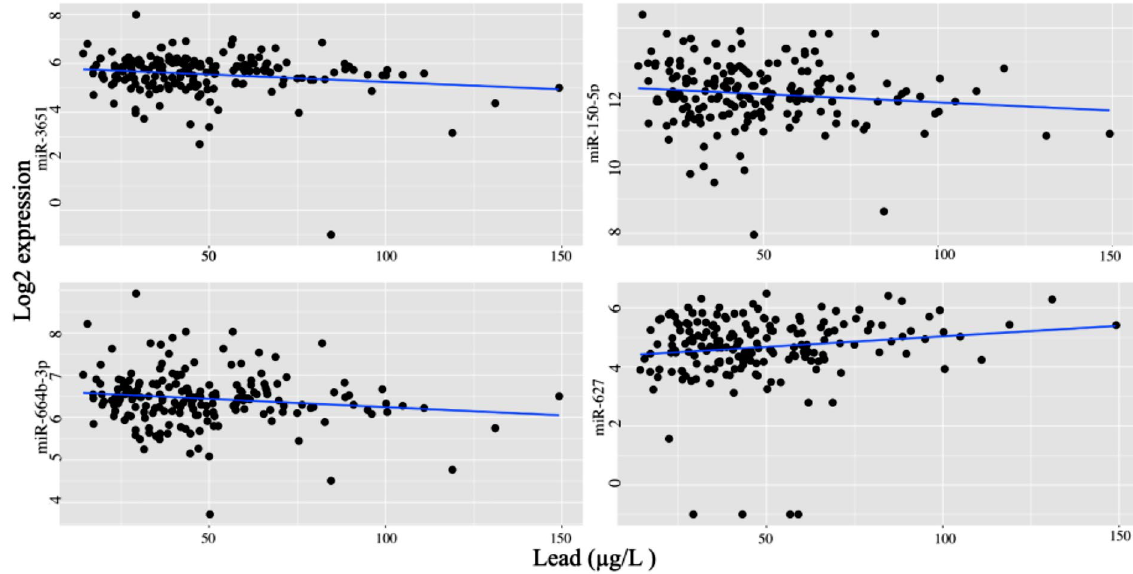
Figure 2. The scatterplot showed expression levels of four miRNAs associated with lead exposure. Scatter plot of the expression of 4 miRNAs (miR-3651, miR-664b-3p, miR-150-5p, and miR-627), identified in the EnviroGenomarker dataset as associated with the lead concentration via a linear mixed model, and plotted against the lead concentration in whole